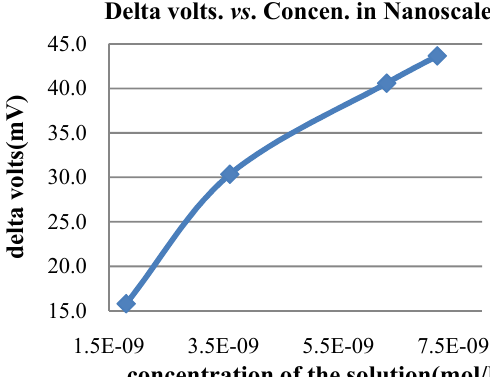
Figure 7. The relationship of the concentrations of the fluorescein solution samples and the voltage differences in nano-scale 10 ×10 − 9